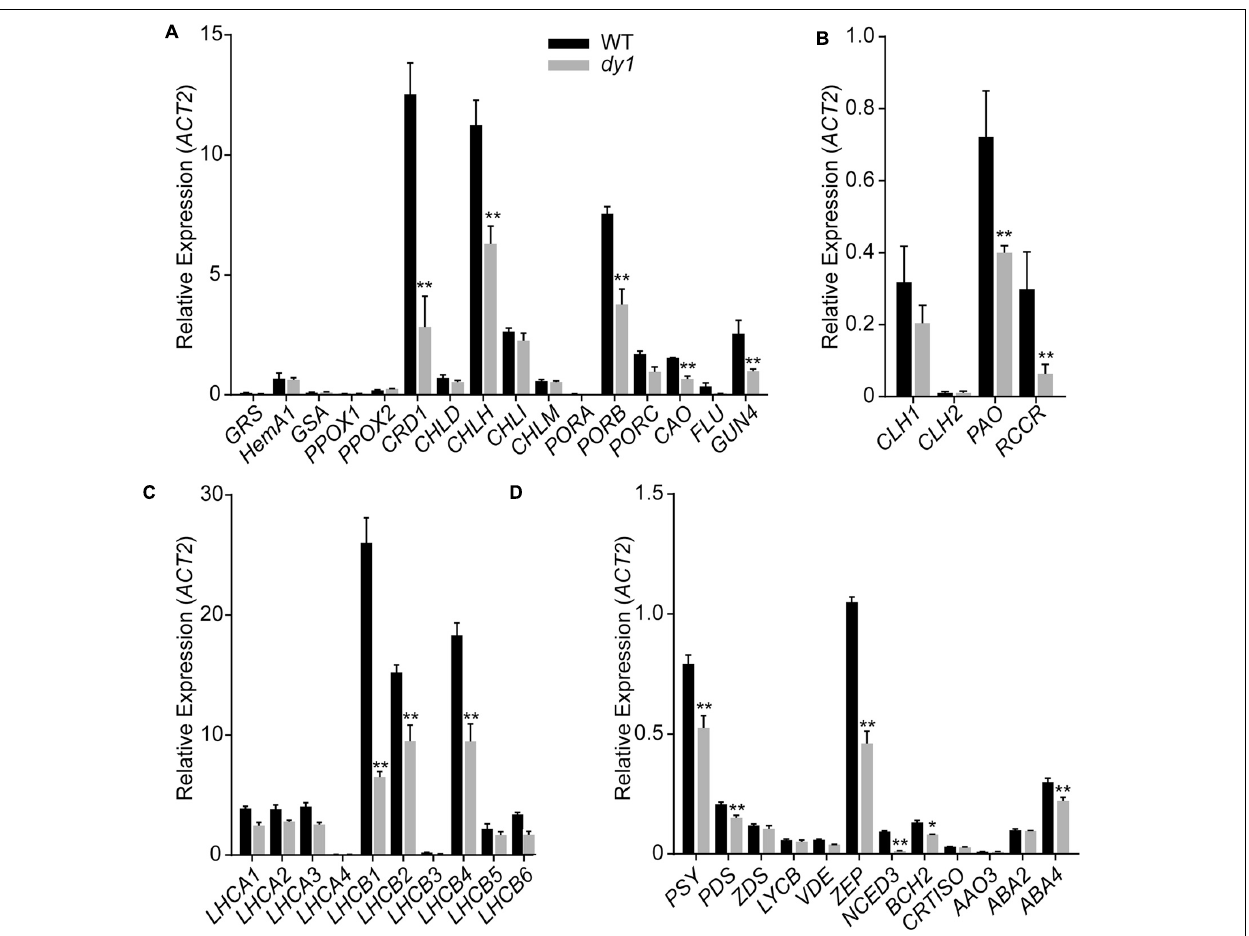
FIGURE 4 | Expression of the genes encoding enzymes for chlorophyll biosynthesis (A) and turnover (B) , chlorophyll-binding proteins (C) and enzymes for carotenoid metabolism (D) in rosette leaves of the 3-week-old dy1 and wild-type (WT) seedlings. Transcript abundance of each gene was determined by quantitative real-time PCR and are normalized against the level of ACT2 ( At3g18780 ). Data represent means ± SD (Student’s t -test; n = 3; ∗ P < 0.05; ∗∗ P < 0.01).